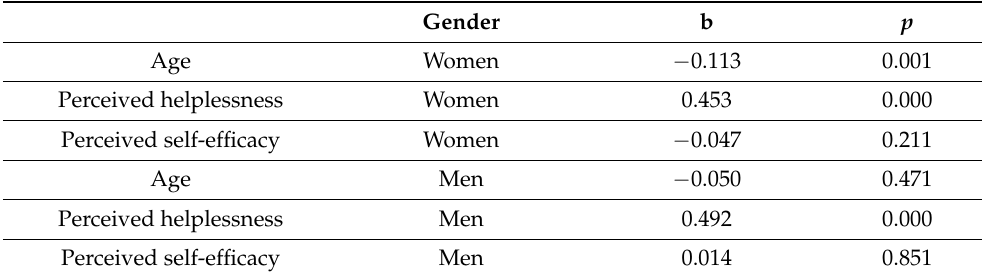
Table 9. Regression results for psychosomatic complaints (dependent variable) and perceived help- lessness and self-efficacy (independent variables) divided by